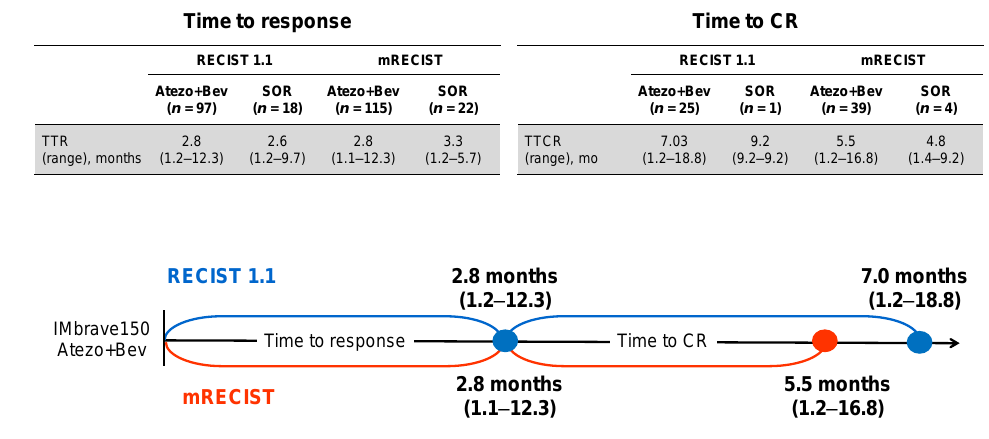
Figure 1. Time to response and time to complete response as per the RECIST v1.1.; modified from [4].